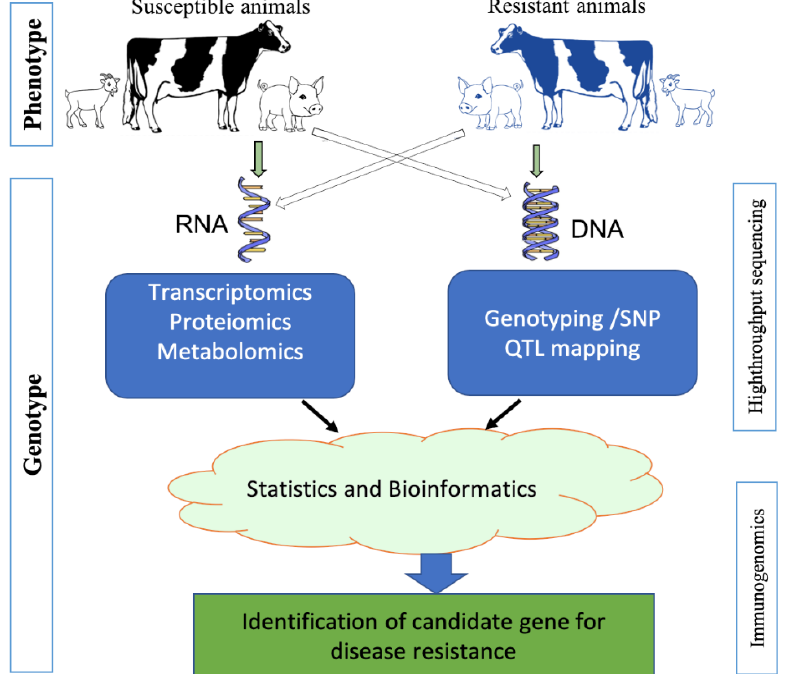
Figure 2. A working pipeline of (in vivo, in vitro, and in silico) immunogenomics for identification of disease resistance candidate gene/marker as prospective targets for genome editing. Isolation of single-cell population of a target from both phenotypic groups followed by RNA and DNA extraction separately. The RNA samples could be employed for proteomics and metabolomics profiling. On the other hand, DNA samples could also be subjected to single nucleotide polymorphisms (NSP) sequencing and genotyping, quantitative trait loci (QTL) mapping, and genome-wide association study, and epigenomics study targeting the disease resistance phenotype. Rigorous integrated bioinformatics application on all sets of omics data together enables us to identify the molecular biomarker for the target immunocompetence trait. After functional validation of the identified biomarkers in the independent population, those could be recommended as the targets for CRISPR / Cas9 mediated genome editing technology.